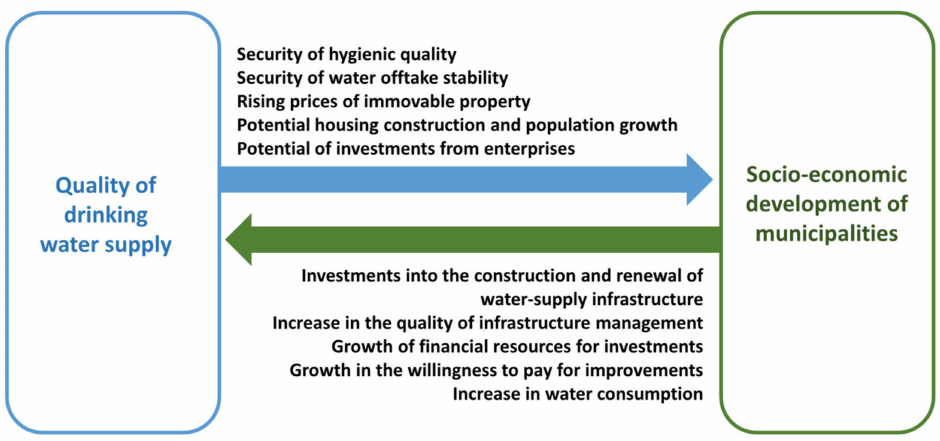
Figure 3. Circular causality scheme: Retroactions between the quality of drinking water supply and the socio-economic development of